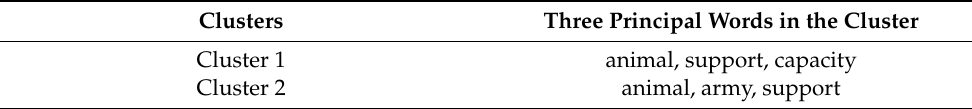
Table 8. Description of the two clusters and the principal words that describe the cluster. Clusters